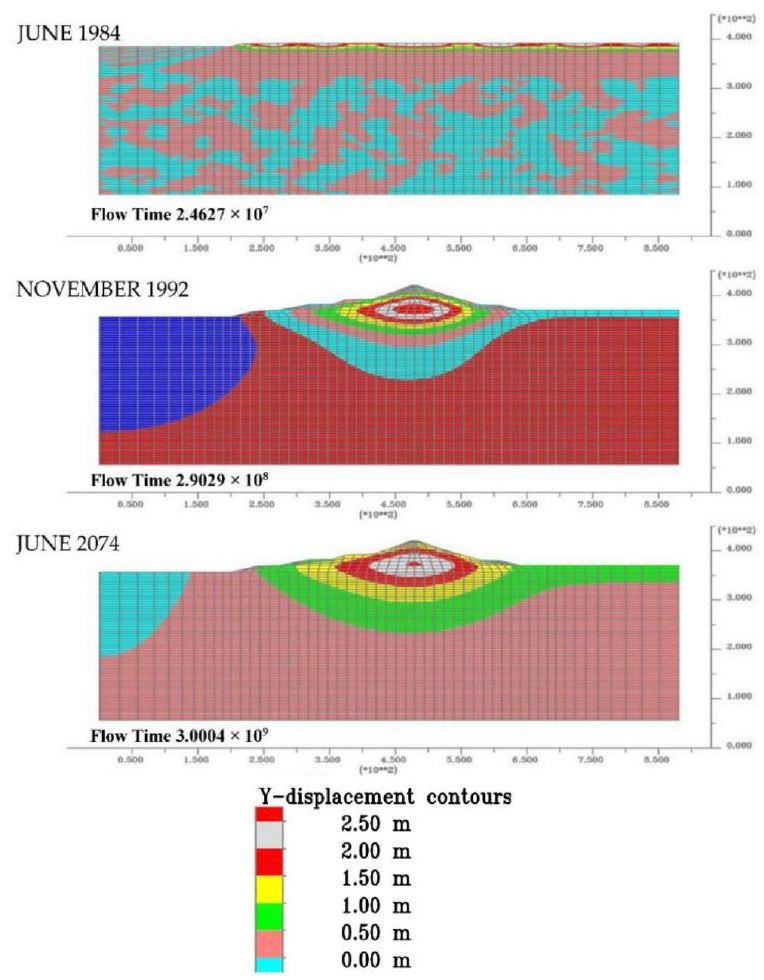
Figure 26. Settlement evolution from the start of dam construction to the end of consolidation.